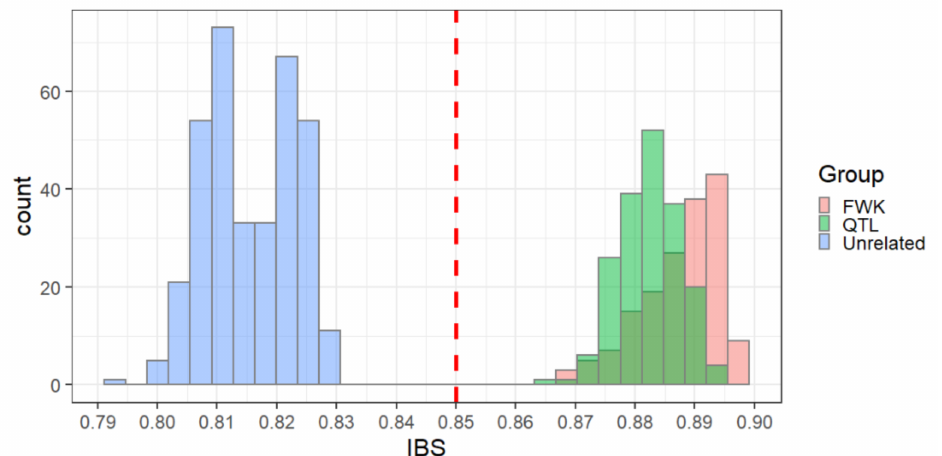
Figure 3. Distribution of identity-by-state (IBS) similarity coefficients within and across families. IBS coefficients between parents and their offspring are shown in green (“QTL” family) and red (“FWK” family). IBS coefficients for unrelated trees in the “QTL” versus “FWK” families are shown in blue. An empirical threshold between unrelated and related trees was set at IBS = 0.85 (red